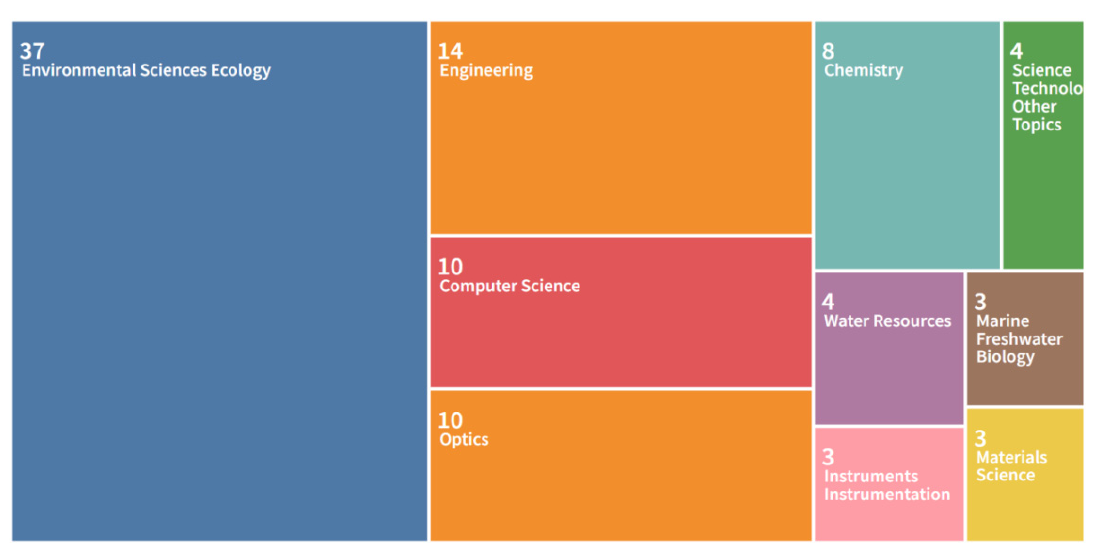
Figure 3. The number and proportion of published papers per year since 2012.